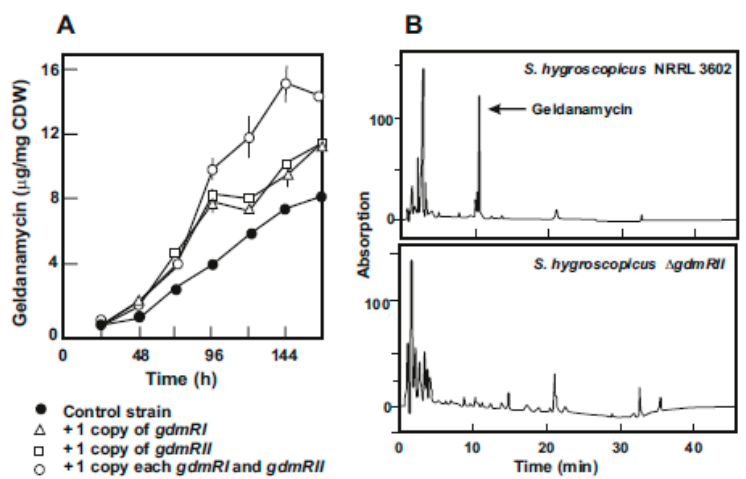
Figure 3. Effect of the regulatory genes on geldanamycin production. ( A ) Production of geldanamycin by S. hygroscopicus var. geldanus NRRL3602 transformed with the empty plasmid pRA (black circles), and the pRA plasmid [38] carrying insertions with the genes gdmRI (white triangles), gdmRII (white squares), and gdmRI + gdmRII (white circles). ( B ) HPLC analysis of geldanamycin production by S. hygroscopicus var. geldanus NRRL3602 (upper panel) and S. hygroscopicus ∆ gdmRII (lower panel) in which gdmRII was deleted. The arrow indicates the geldanamycin peak.